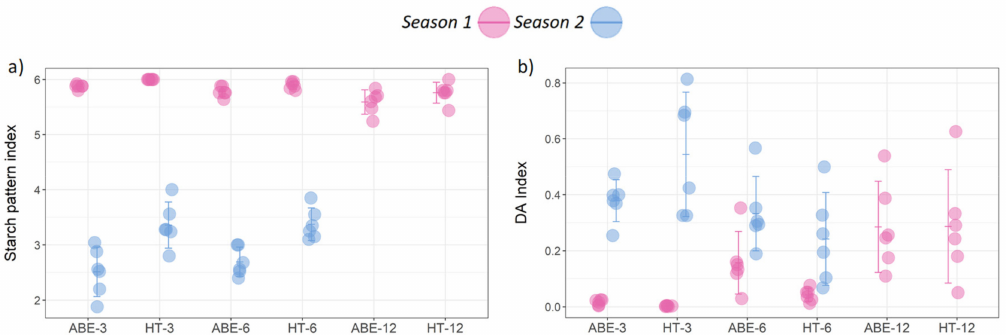
Figure 5. Effect of thinning regime and crop load on fruit maturity parameters at harvest: ( a ) Starch pattern index, and ( b ) DA index under different treatments across two seasons (error bars represent 95% confidence interval). ABE = artificial bud extinction; HT = hand